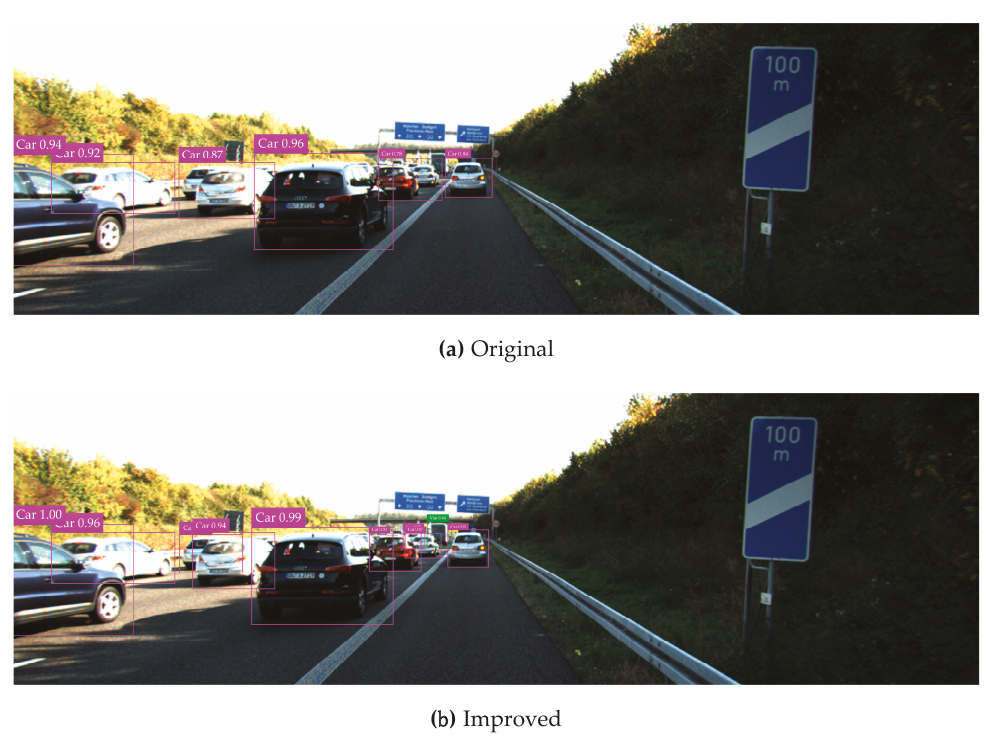
Figure 11. Vehicle detection test results at the road intersection based on the original and improved SSD.